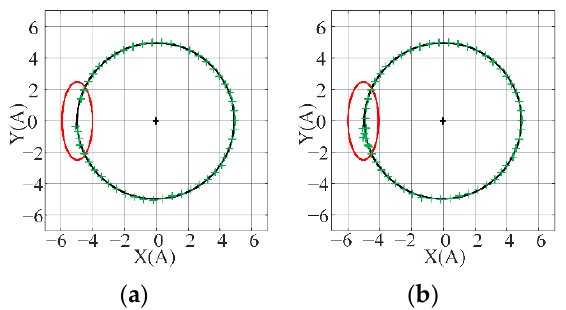
Figure 3. Ellipse fitting of Park vector trajectory when motor frequency and load fluctuate: ( a ) frequency decreases. ( b ) Frequency increases.